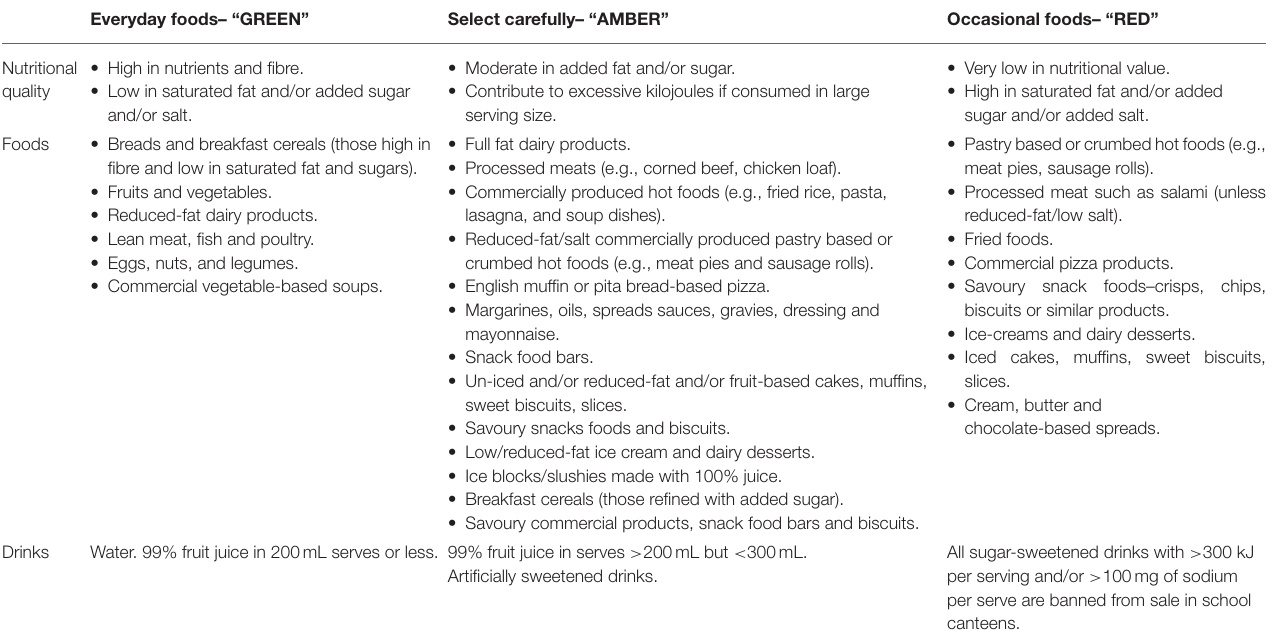
TABLE 1 | Food classification description. Everyday foods– “GREEN” Select carefully– “AMBER” Occasional foods– “RED” Nutritional